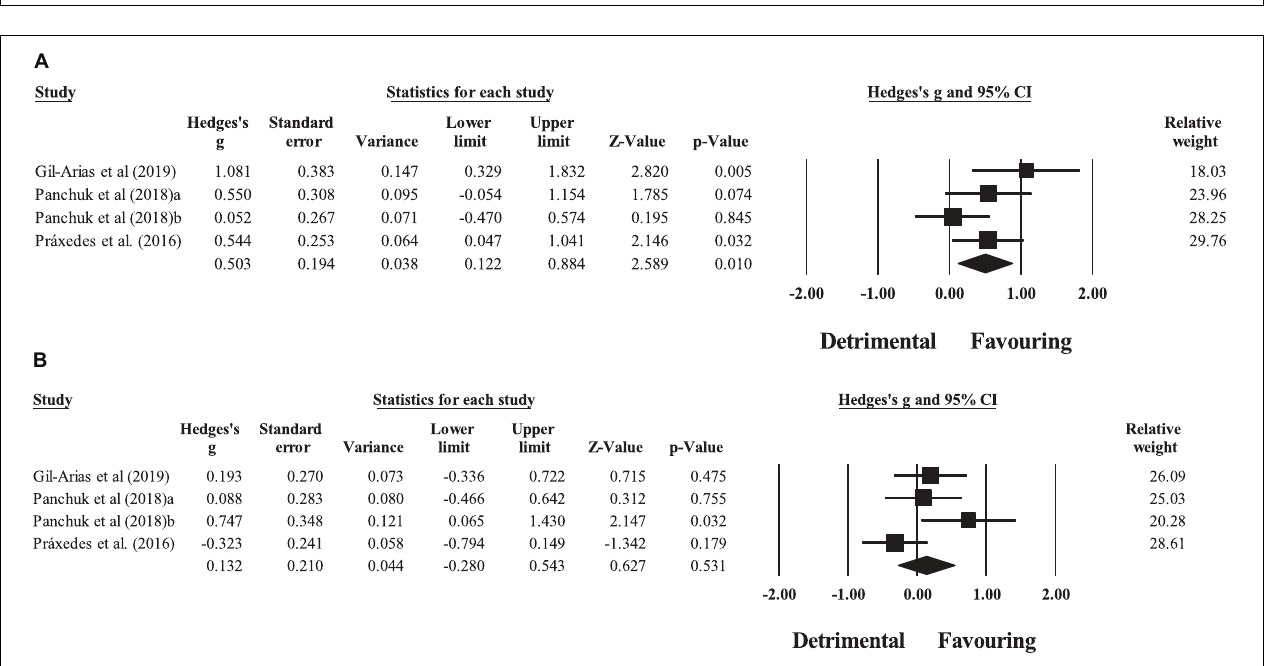
FIGURE 5 | Forest plot of changes in technical execution, in youth athletes from team sports participating in decision-making training (intervention) compared to controls. Values shown are effect sizes (Hedges’s g ) with 95% confidence intervals (CI). The size of the plotted squares reflects the statistical (relative) weight of the study.